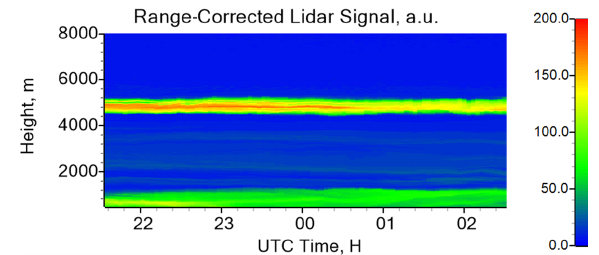
Figure 4. Range-corrected lidar signal at 1064nm on 23–24 June 2020, revealing a smoke layer between 4500 and 5200m